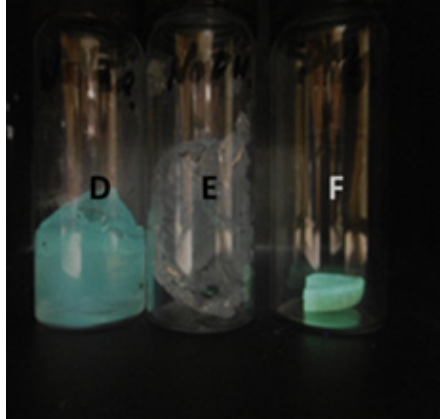
Figure 6. Vials D-F irradiated with 365 nm UV light in a dark cabinet. Vial D contains a hydrated polyacrylamide hydrogel embedded with 5 in the presence of APS. Vial E contains a hydrated hydrogel with 5 , APS and 0.5 M NaOH solution, which turns off the fluorescence. Vial F contains a dried fragment of solid polyacrylamide with 5 emitting a green fluorescence.